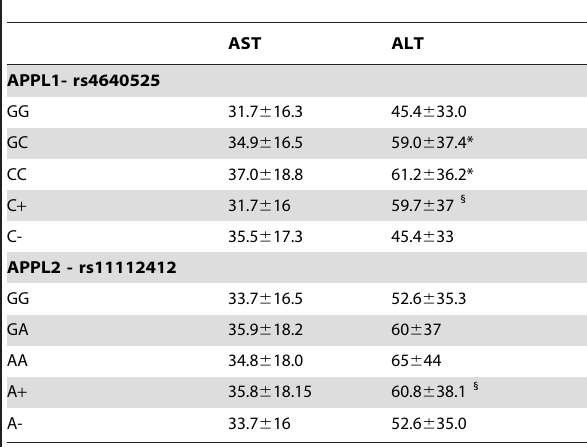
Table 4. Levels of alanine transaminase (ALT) and aspartate transaminase (AST) among different APPL1 and APPL2